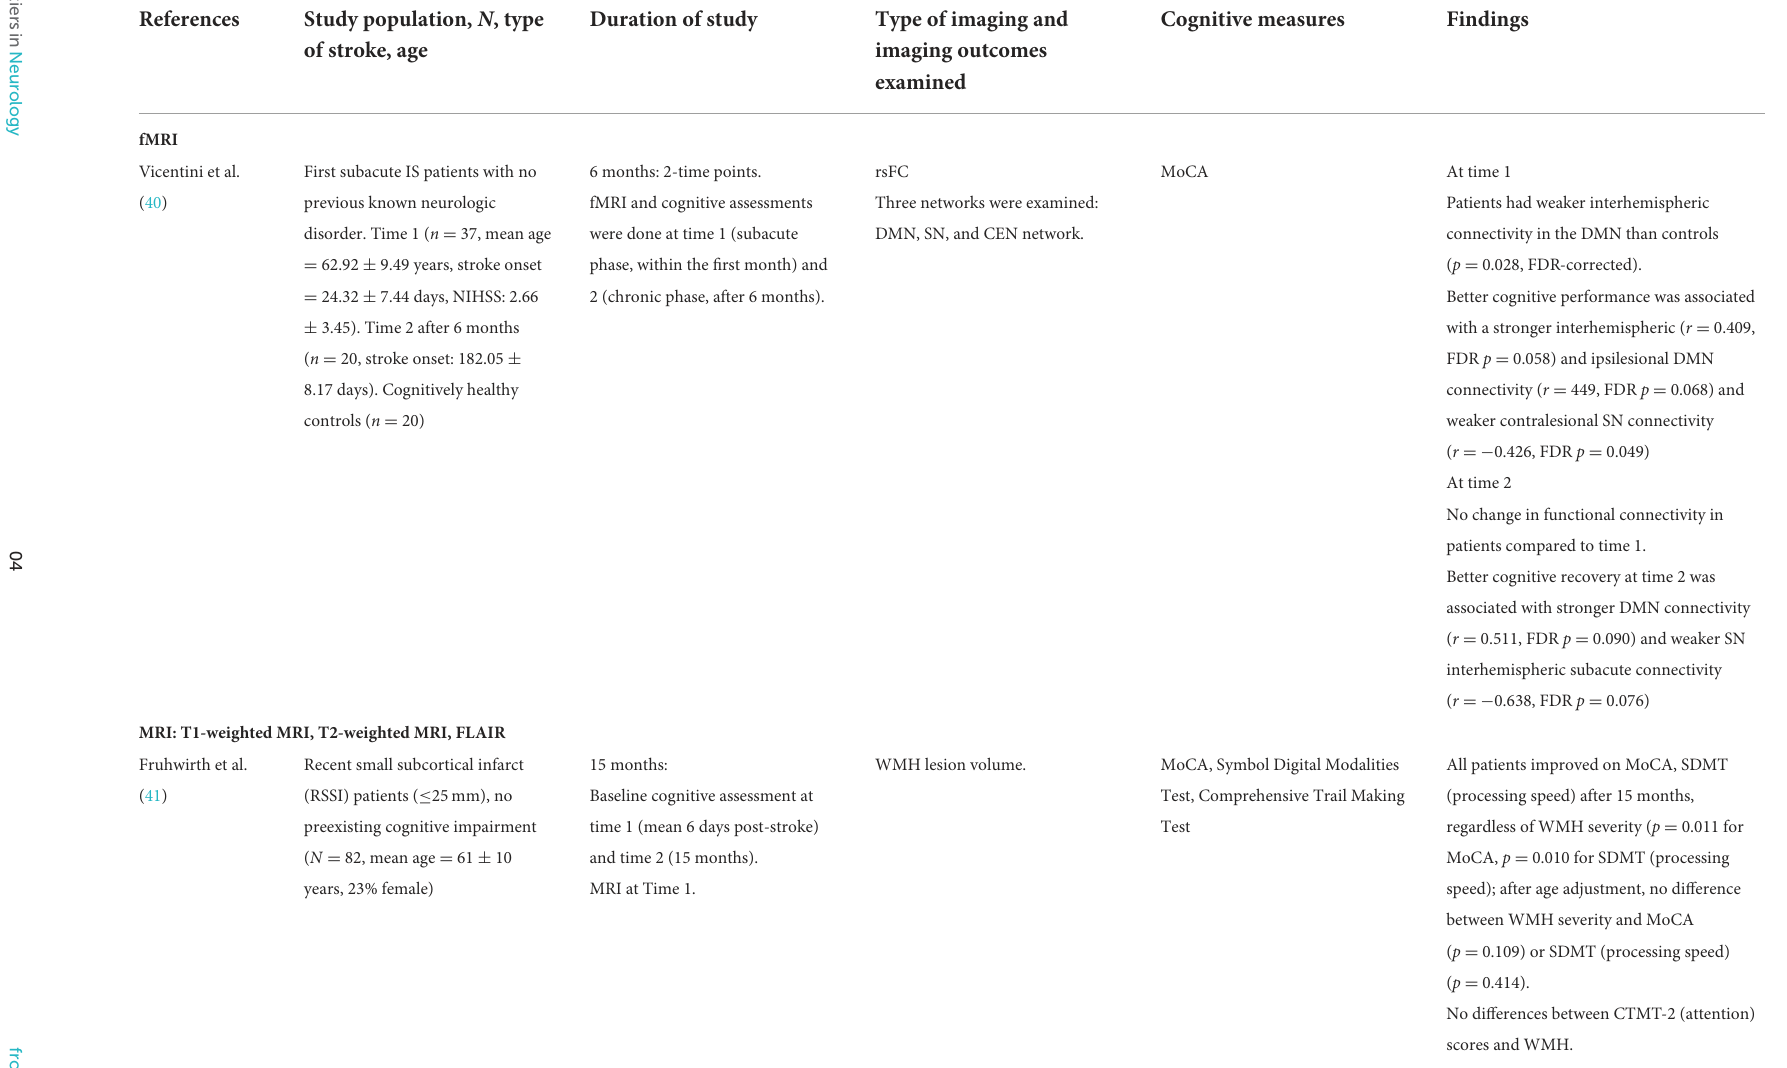
TABLE 1 Summary of key studies within the last 10 years on neuroimaging biomarkers of cognitive recovery after ischemic